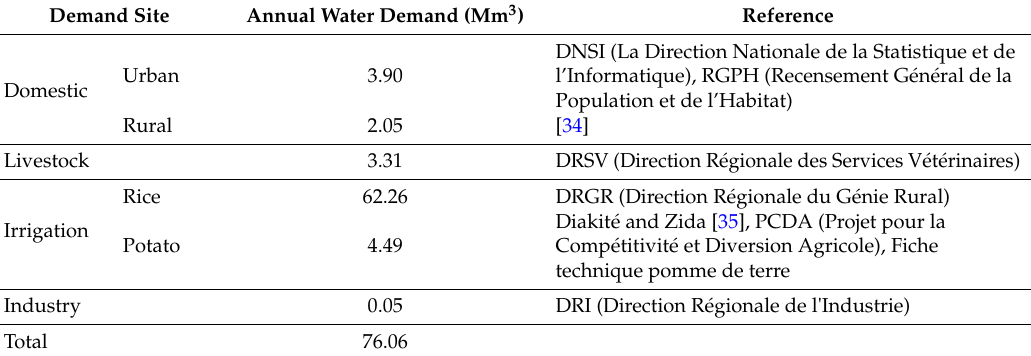
Table 2. Water demand data for current account for the year 2013 in million cubic meters (Mm 3